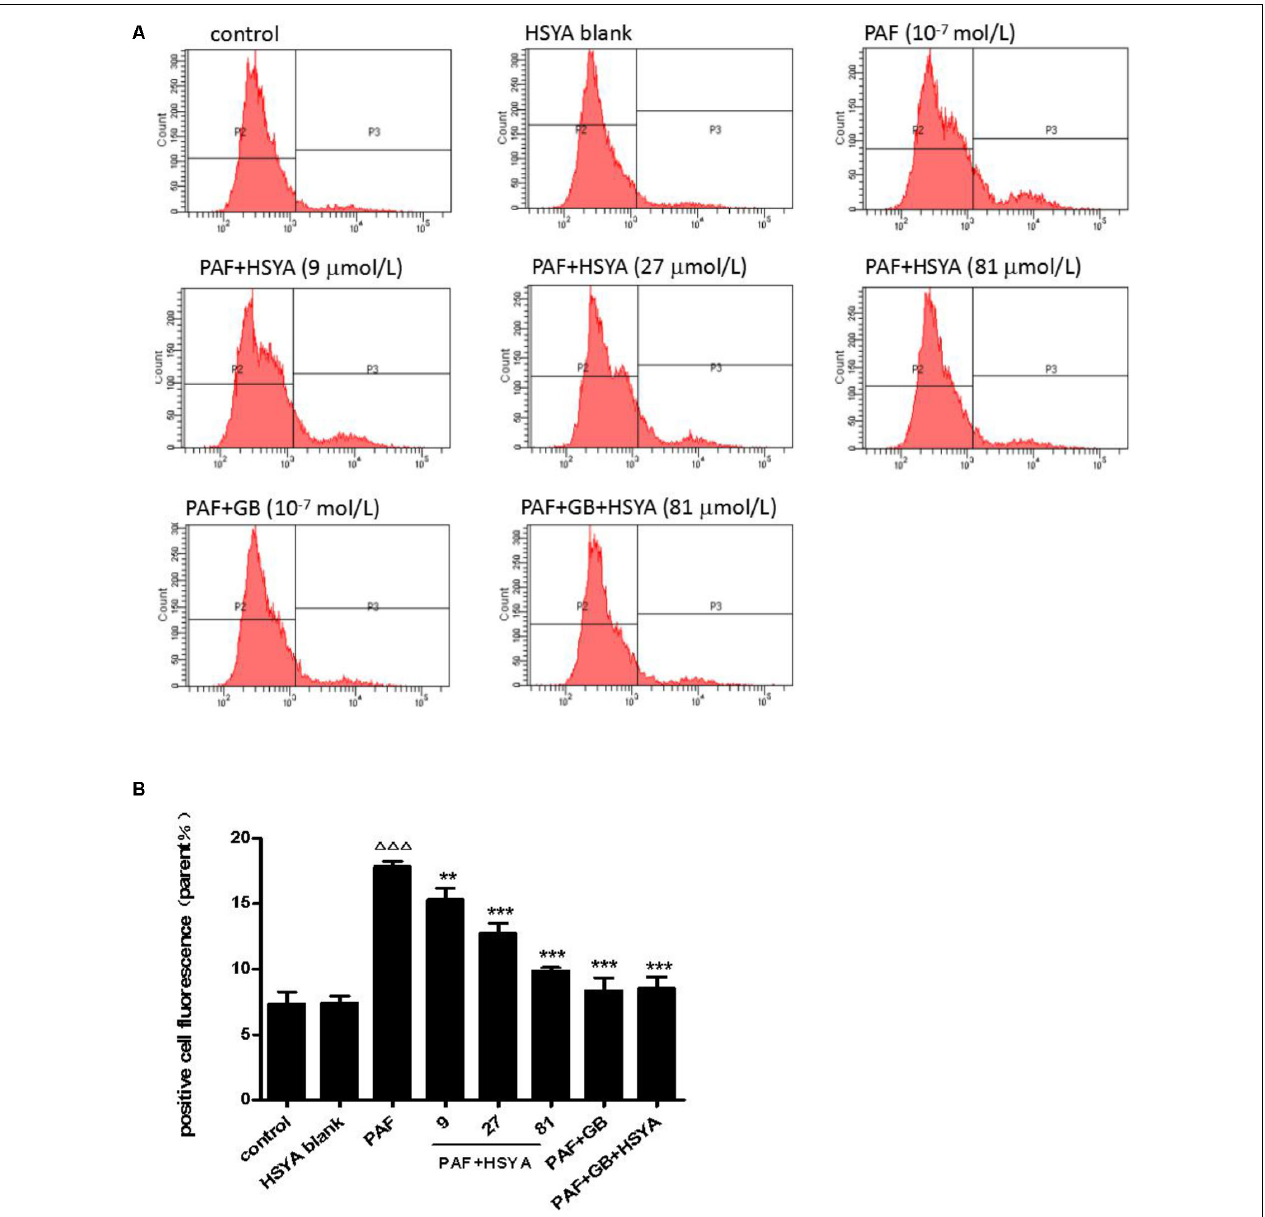
FIGURE 6 | Effect of HSYA on intracellular calcium levels in PAF-stimulated HSAECs, detected by flow cytometry (A, B) . Data presented as mean ± SD, n = 3 per group. ANOVA, p < 0.0001, post hoc (cid:49)(cid:49)(cid:49) p < 0.001 versus control group, ∗∗ p < 0.01, ∗∗∗ p < 0.001 versus PAF group.